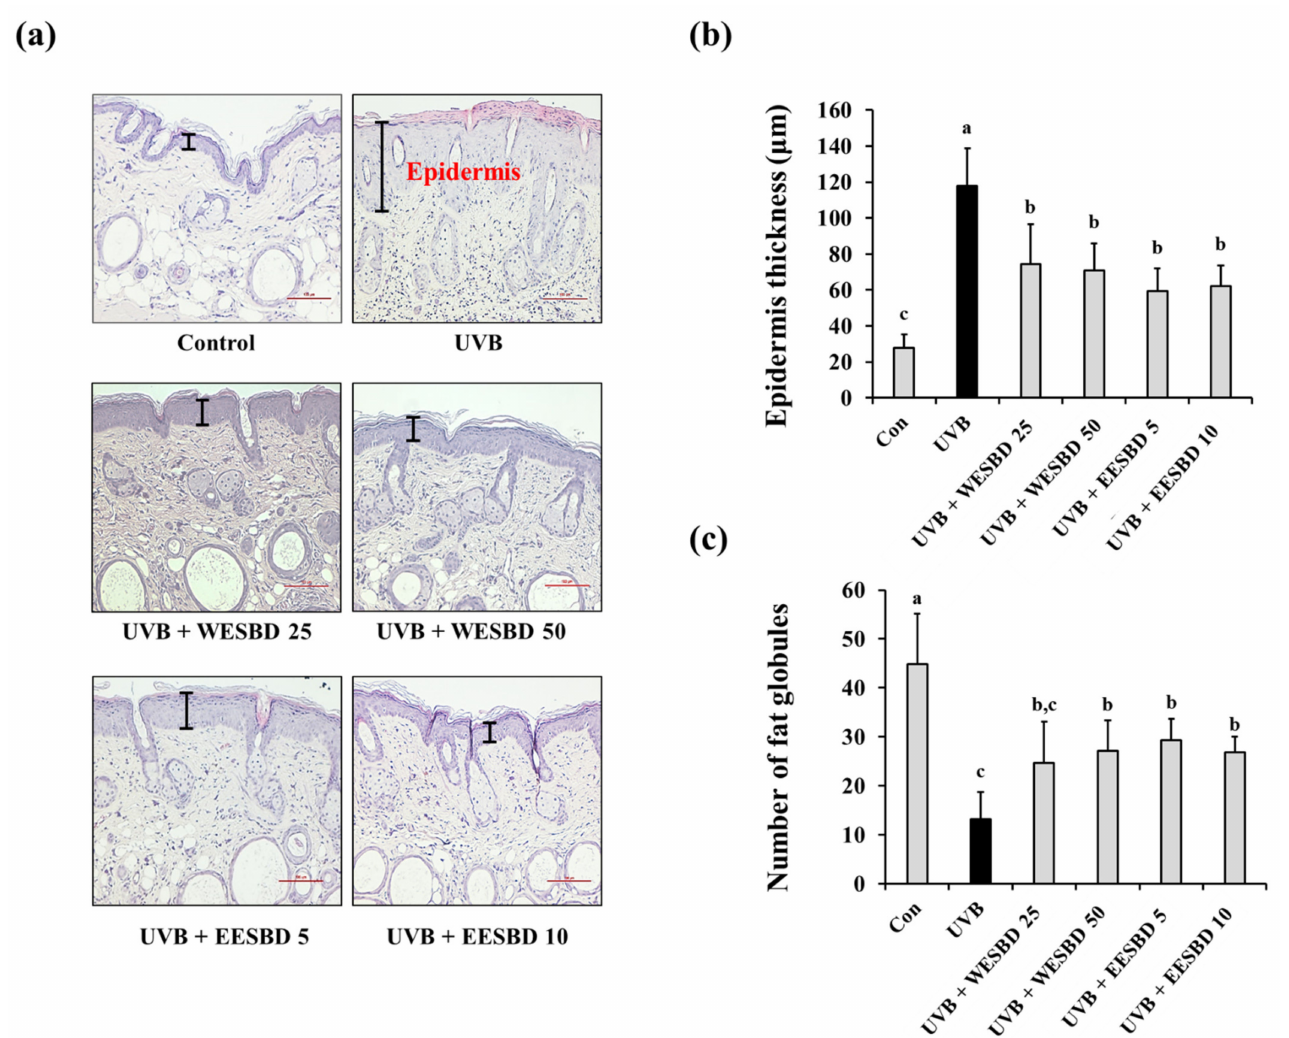
Figure 4. Effect of topical administration of water extract of S. barbata D. Don (WESBD) and ethanol extract of SBD (EESBD) on the epidermal thickness of hairless UVB-irradiated murine skin. Dorsal skin tissues ( n = 7) were separated and fixed with 4% ( w / v ) paraformaldehyde solution, and the skin tissues were then embedded in paraffin and sliced into sections 5 µ m thick and stained with hematoxylin and eosin (H&E) ( a ). The thickness of the epidermis ( b ) and number of globules in the dermis ( c ) in each mouse group were calculated under a microscope and tabulated. Data are presented as the mean ± SD. Different letters indicate a significant difference between groups ( p <